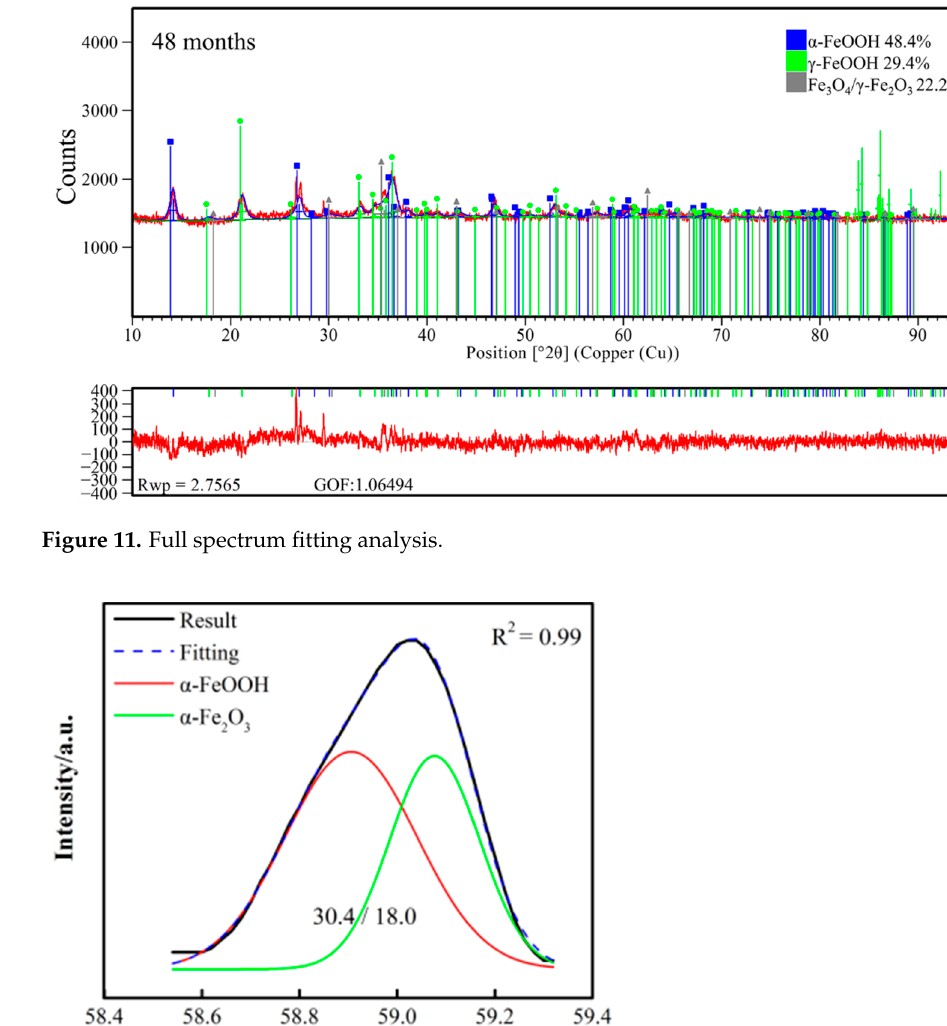
Figure 10. Structure of the rust layer phase.